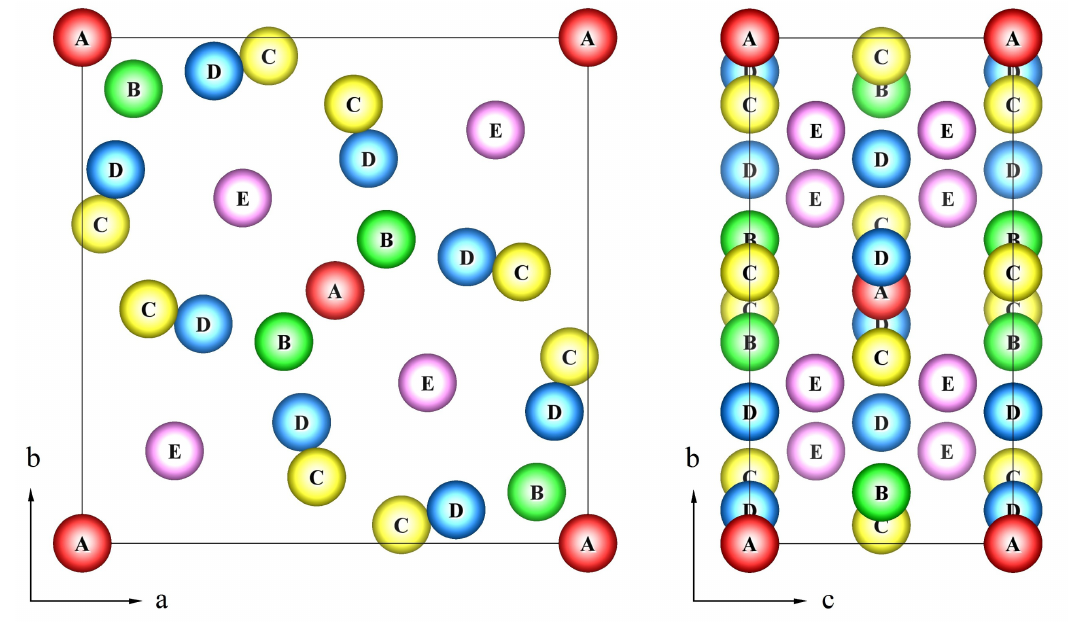
The tetragonal unit cell of the σ -phase structure with 5 crystallographically inequivalent sites (A, B, C, D,